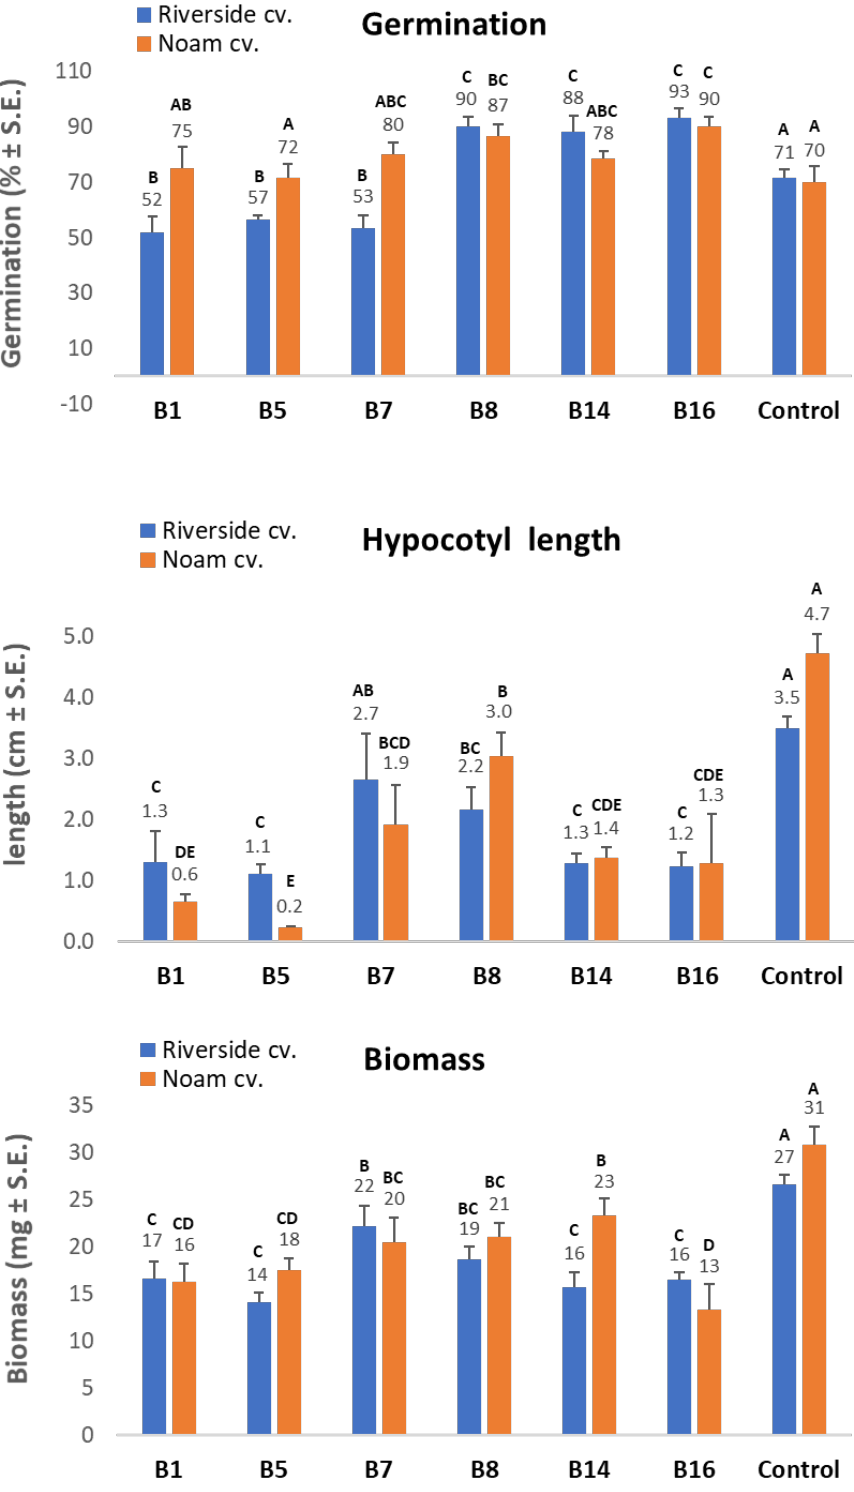
Figure 8. Growth of infected seedlings. The pathogenicity test using un-germinated seeds was conducted, as presented in Figure 7. The six Fusarium isolates were added to seeds in vitro , and the seedlings’ germination (damping-o ff ) rate, hypocotyl elongation, and fresh biomass were measured nine days after incubation at 28 ± 1 ◦ C in the dark. Vertical upper bars represent the standard error of the mean of six replications (Petri dishes, each containing 10-15 seeds). Di ff erent letters above the error bar indicate a significant di ff erence ( p < 0.05); the same letters indicate no significant di ff